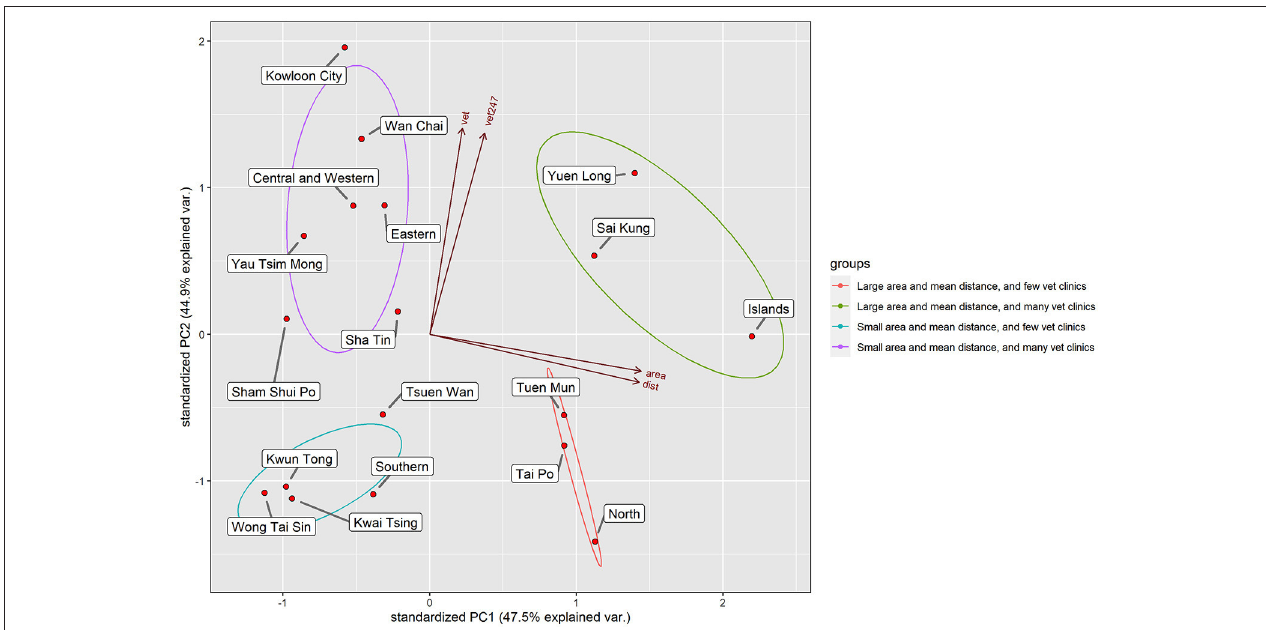
FIGURE 4 | The biplot of the reprojected values on PC1 and PC2. The arrows are the eigenvalues and eigenvectors of each